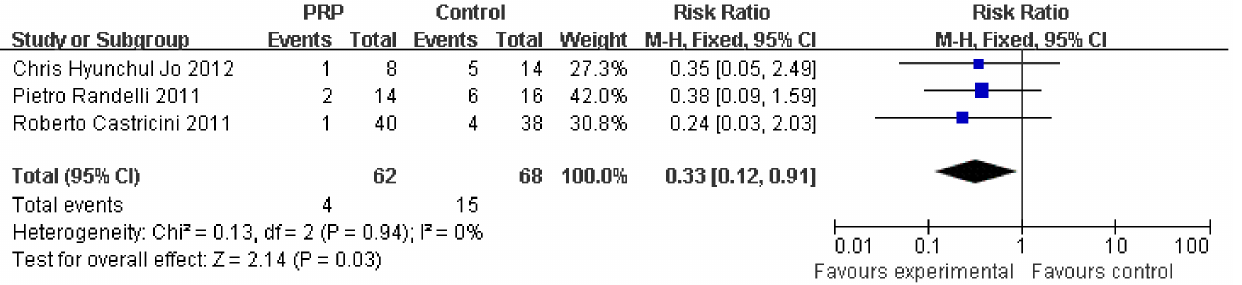
Figure 8. Difference in the retear rate of small- and medium-sized rotator cuff.